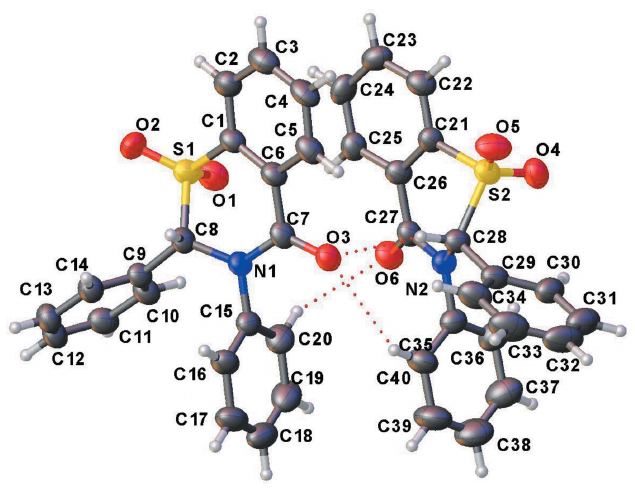
Figure 1 The asymmetric unit of 1 with displacement ellipsoids drawn at 50% probability level.